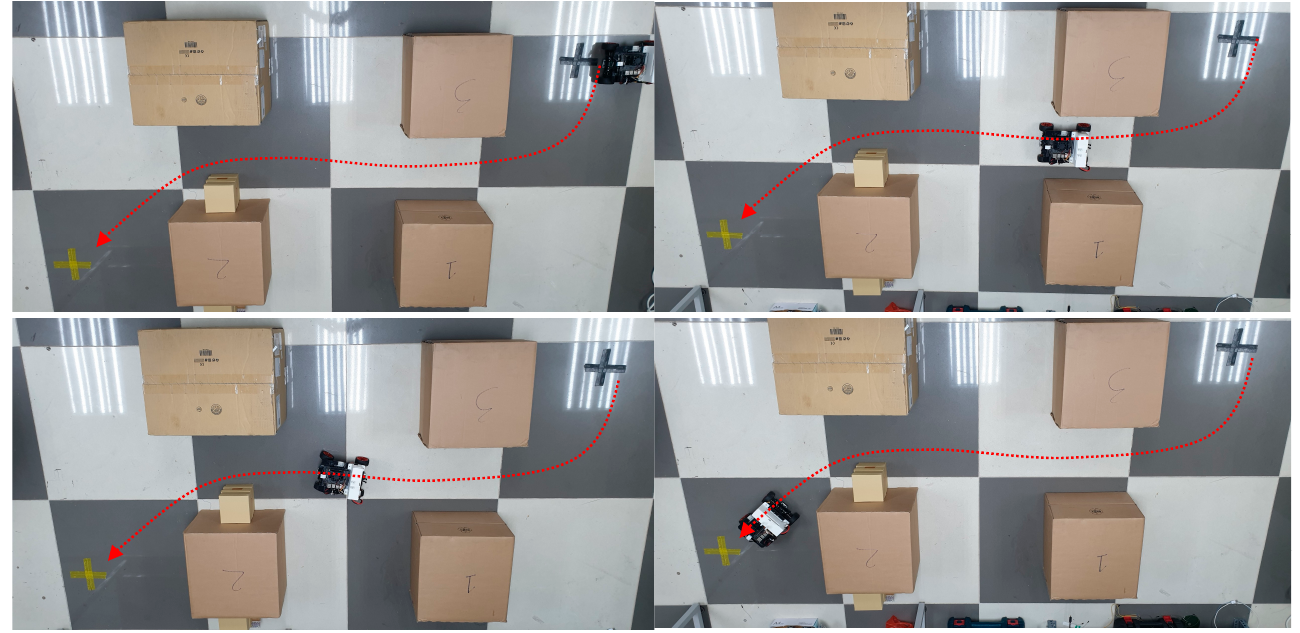
Figure 25. Mobile robot path in experimental four obstacles scenarios.